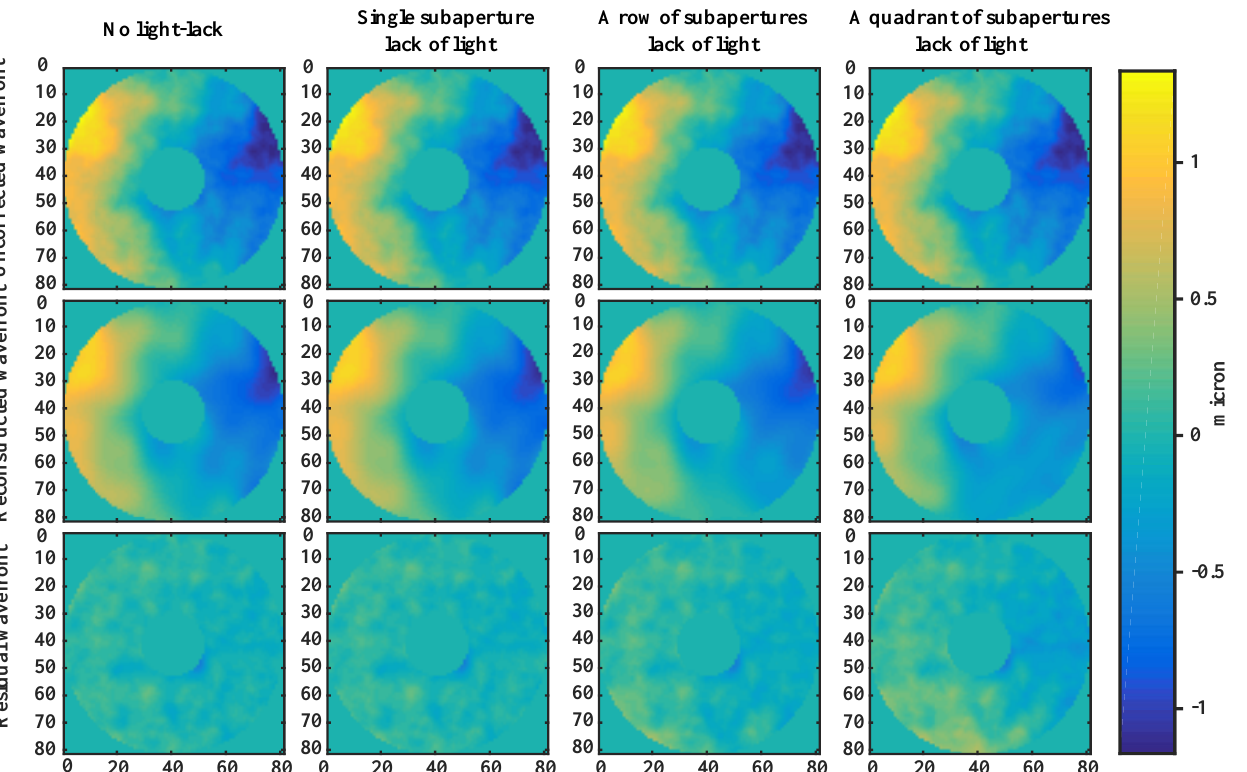
Figure 5. For r 0 is 10 cm, the aberrant wavefront, reconstructed wavefront, and the residual wavefront. The residual error increases rapidly with the increasing number of sub-apertures.